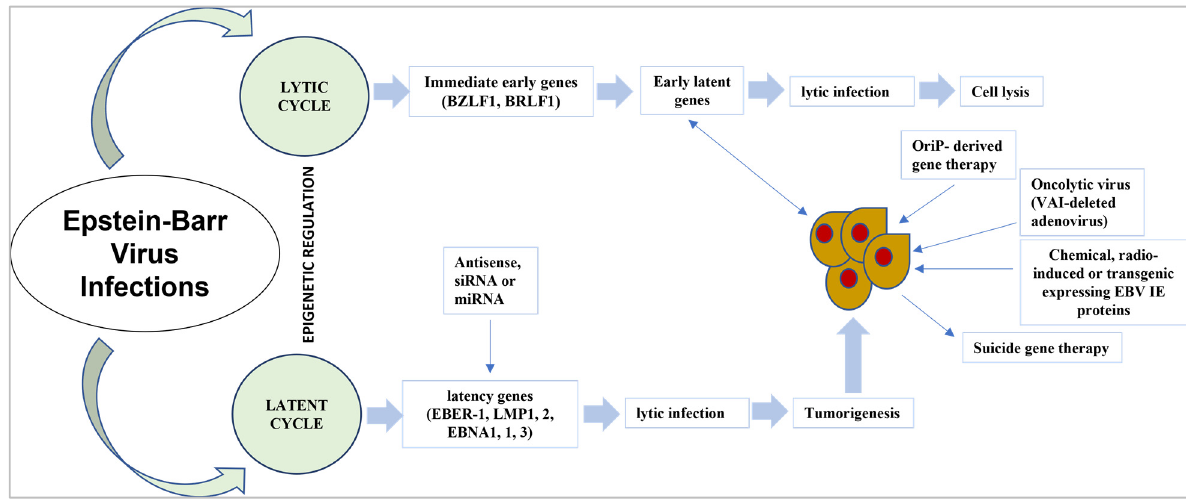
Figure 2. Strategy for EBV targeted gene